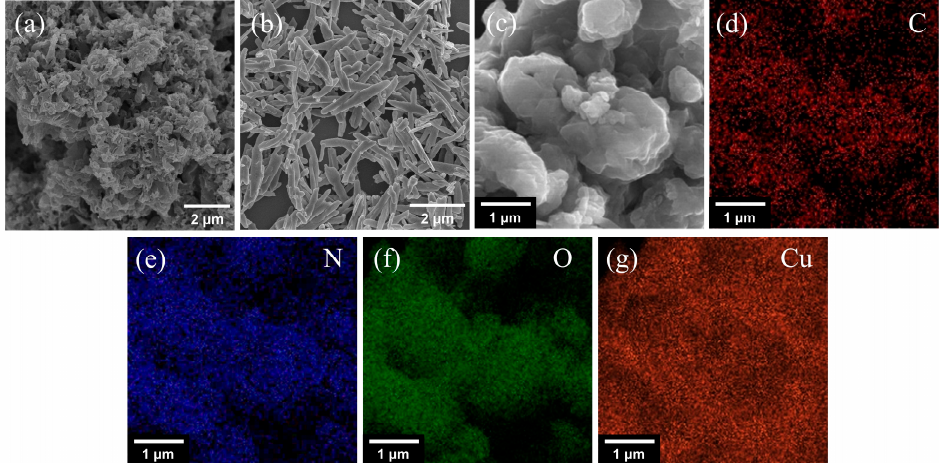
Figure 6. FESEM images of ( a ) g-C 3 N 4 , ( b ) CuO NSs, ( c ) CuO/g-C 3 N 4 , and ( d – g ) elemental mapping results of C (red), N (blue), O (green), and Cu (orange) of CuO/g-C 3 N 4 .